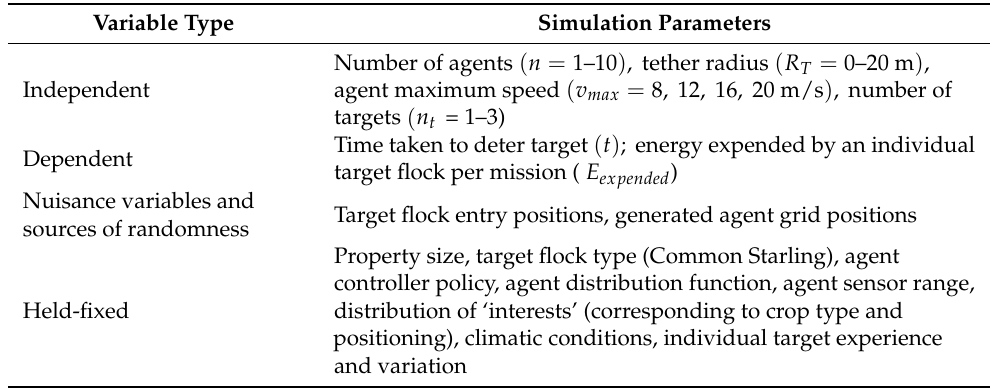
Table 2. Simulation parameter definitions and